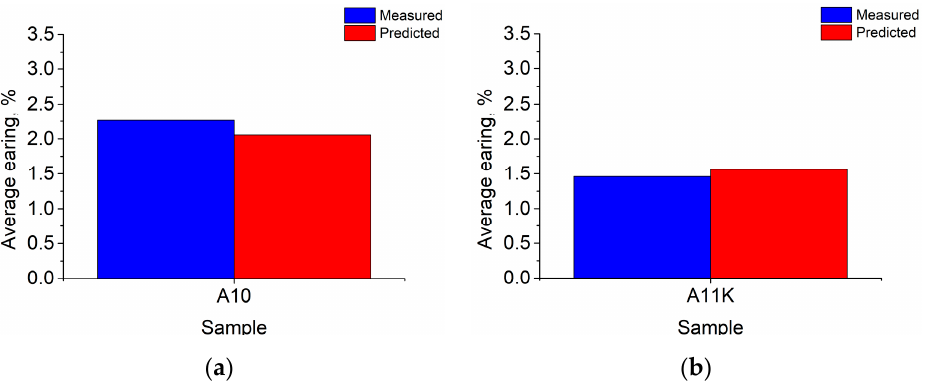
Figure 7. Absolute value of average earing of the samples cold-rolled in 12 steps. ( a ) Measured and predicted average earing of the unidirectionally rolled sample, scaling factor: 40; ( b ) measured and predicted average earing of the cross-rolled sample, scaling factor: 60.